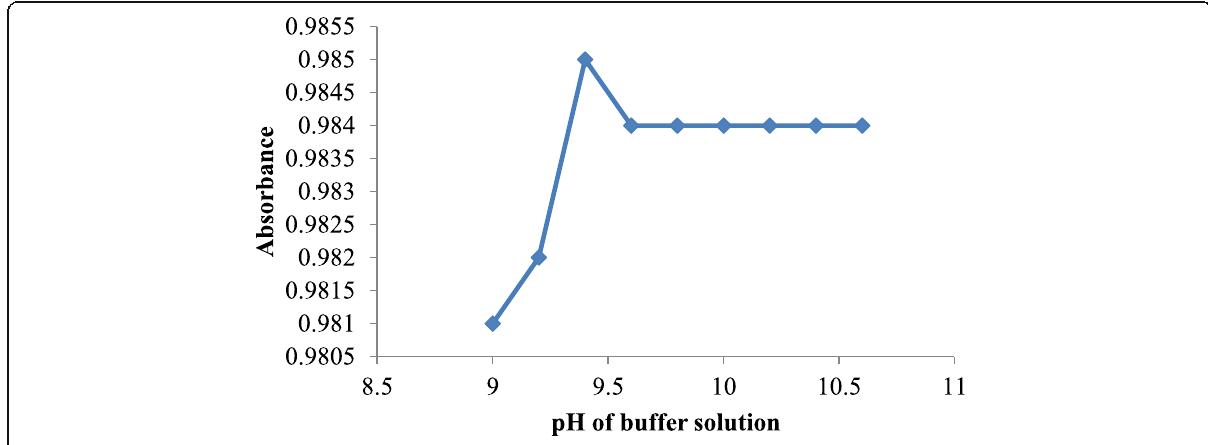
Fig. 5 Effect of pH of buffer solution on the reaction product